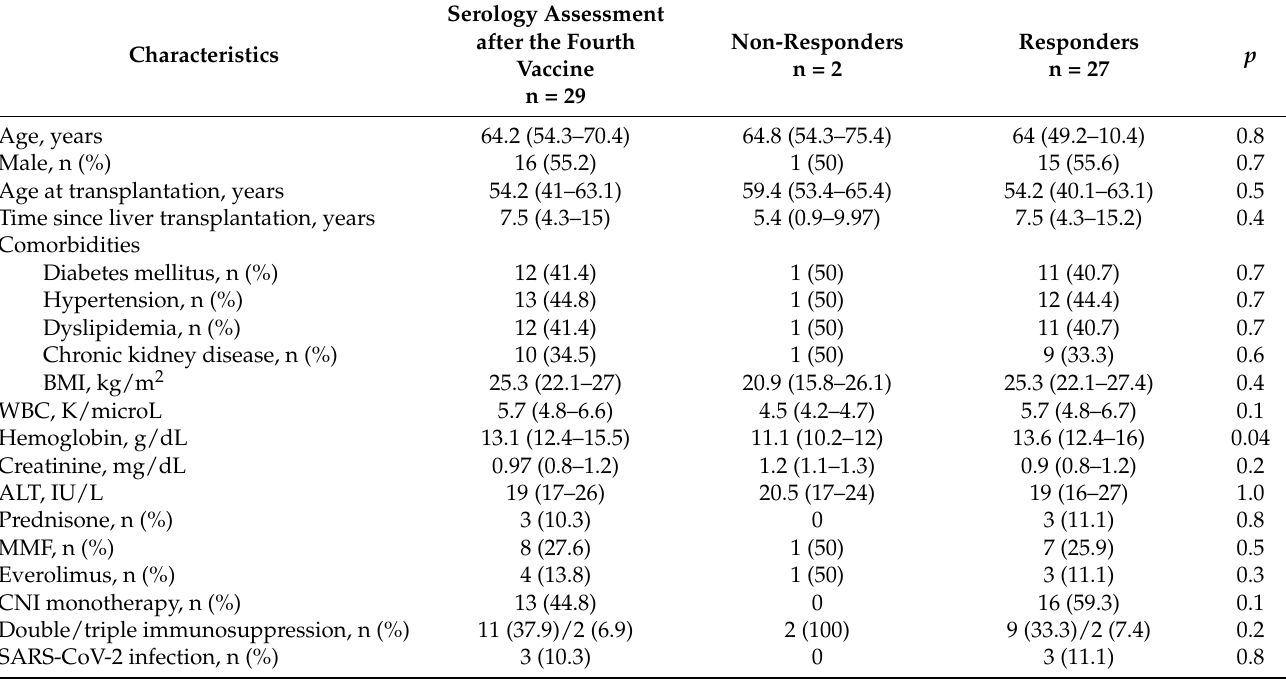
Table 4. The Humoral immune response of 29 patients after being vaccinated with a fourth dose of the BNT162b2 mRNA